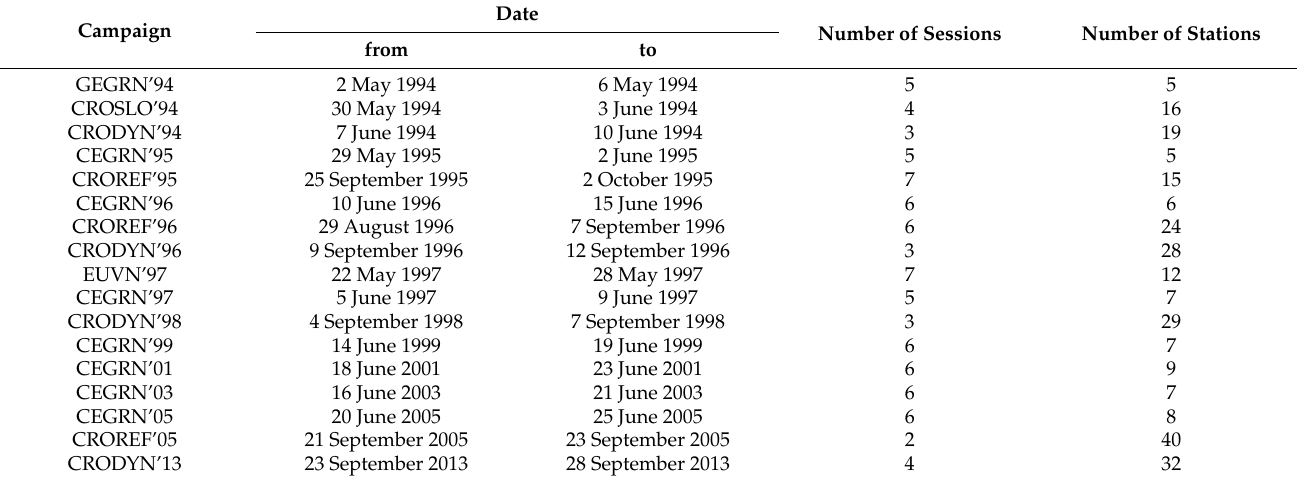
Table 1. General information on GPS campaign data (17) used for Croatian